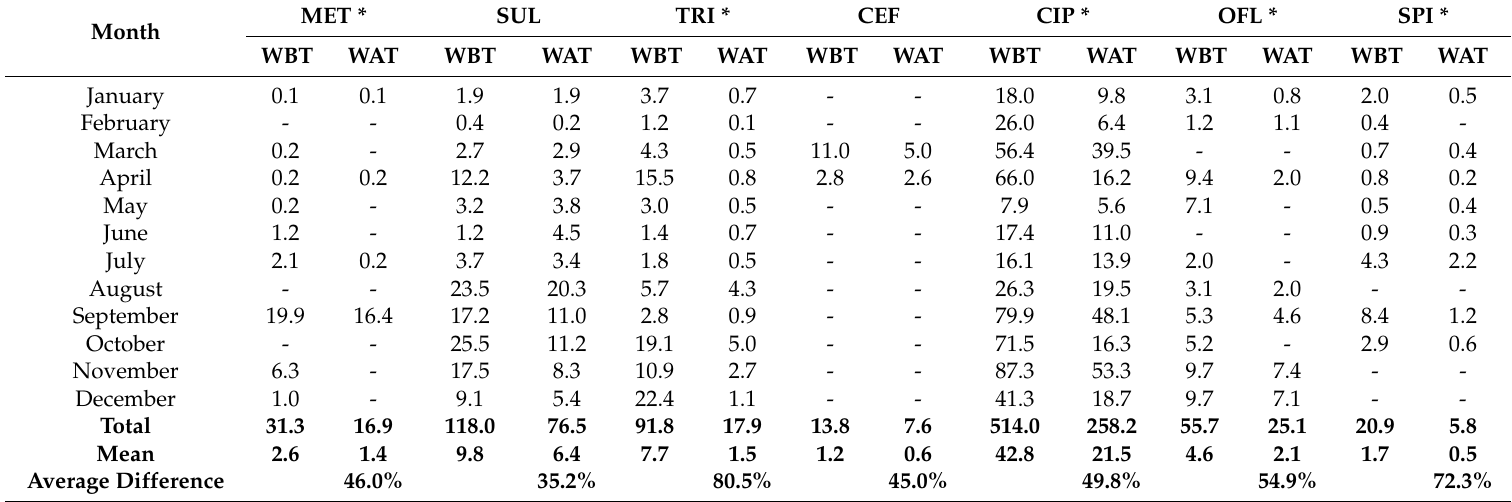
Table 2. Concentrations ( µ g/L) of studied antibiotics in wastewater of a rural hospital in